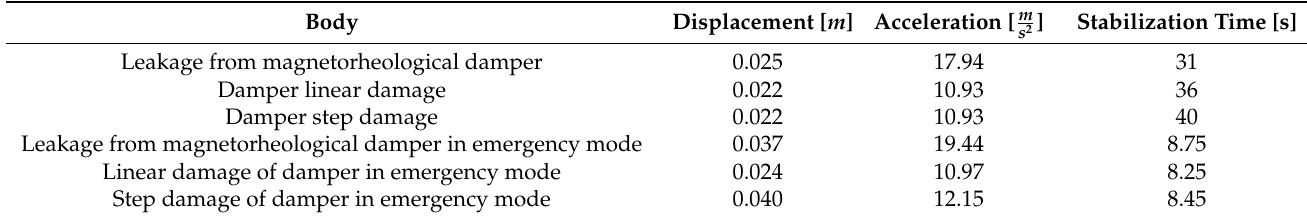
Figure 11. Body vertical acceleration for a linearly damaged damper with introduction of an emergency mode. Table 1. Table of results of extreme